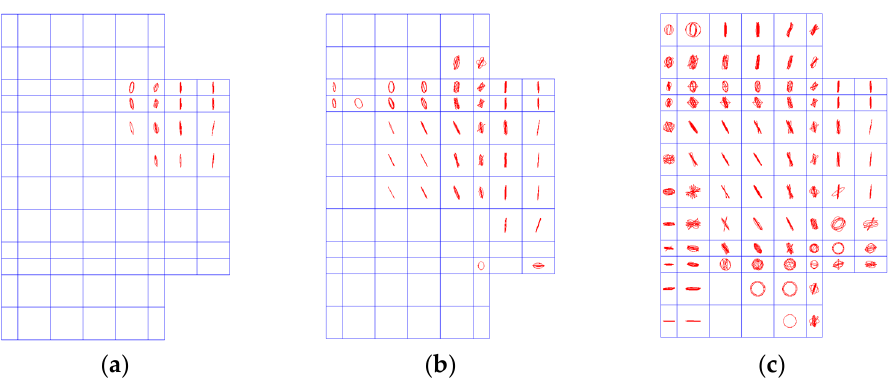
Figure 12. Crack propagation in Specimen TJ-1. ( a ) 17.9% of ultimate load; ( b ) 40.6% of ultimate load; ( c ) 95.9% of ultimate load.